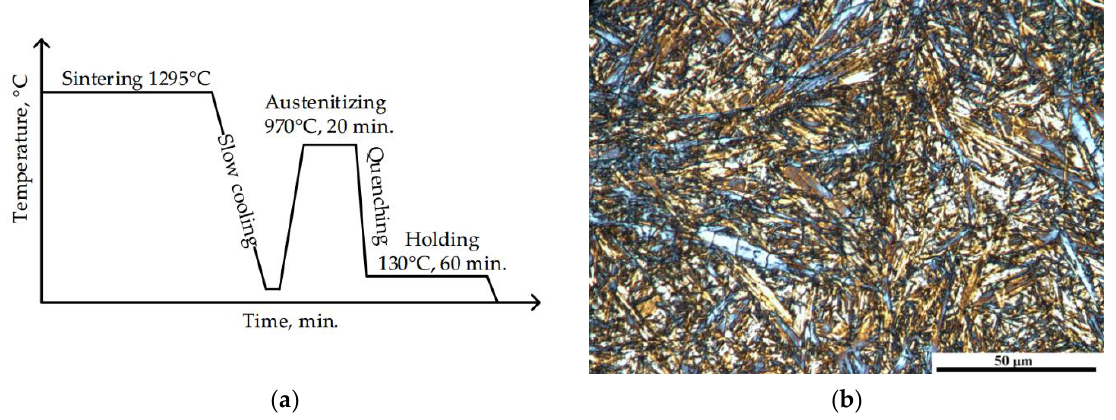
Figure 1. Heat treatment diagram ( a ) and microstructure of quenched steel ( b ). The quenched specimens were Electrical Discharge Machining (EDM) machined to cylinders of height h ~ 11 mm and diameter d 7 mm for thermo-mechanical compression on a Bähr MDS 830 plastometer-dilatometer at strain rates of 0.001, 0.01, 0.1, and 1 s − 1 at 775 ◦ C. This temperature corresponds to the austenitization end temperature. Changes in diameter were measured with a laser dilatometer and are presented as a function of temperature in Figure